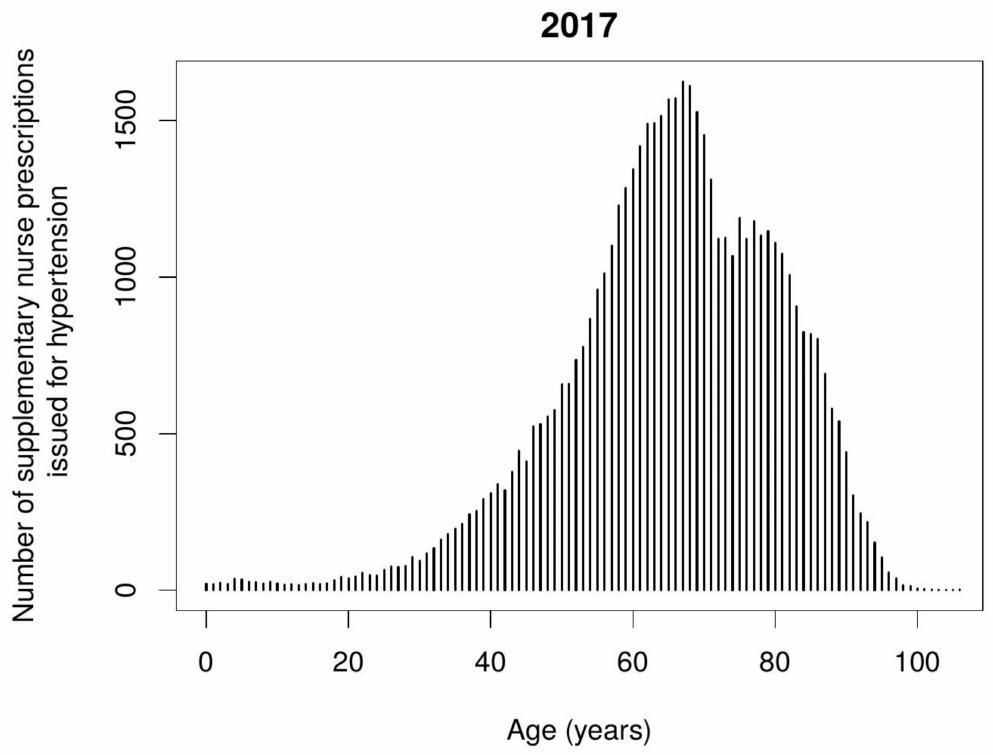
Figure 3. Number of nurse supplementary prescriptions issued for hypertension therapy during the second year of implementing period depending on the patient’s